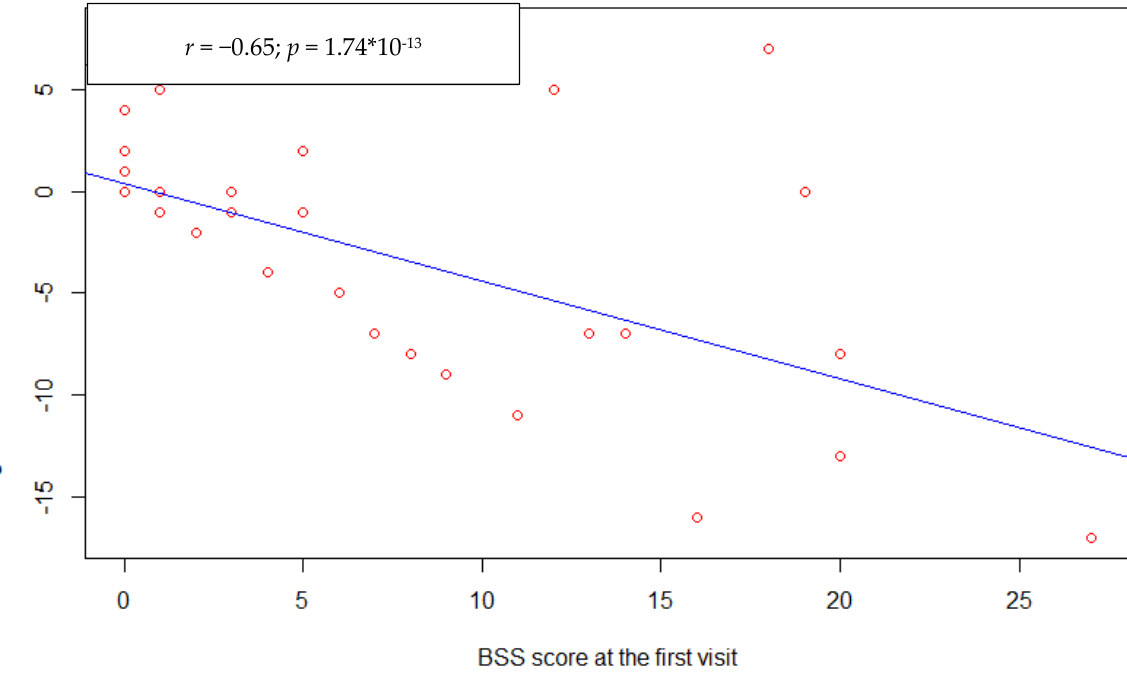
Figure 4. Correlation between BSS score at the first visit and its change between the two visits .